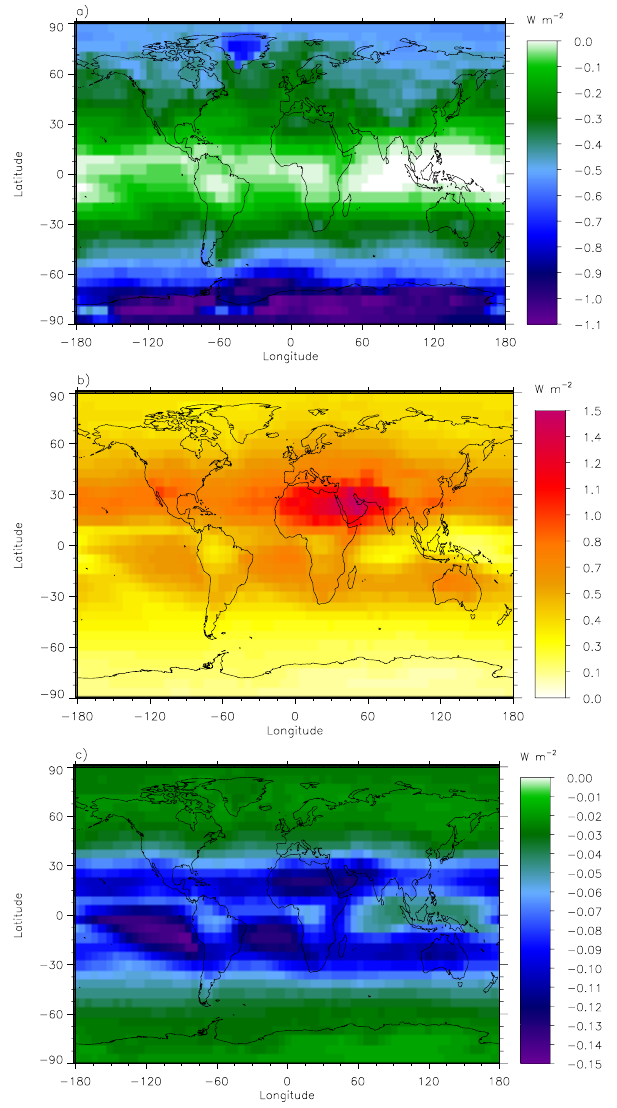
Fig. 8. The radiative forcing due to changes in atmospheric O 3 between the pre-industrial times and the present, for the R2 simu- lations. (a) shows the RF for the change in stratospheric O 3 , (b) the RF for the change in tropospheric O 3 , while (c) shows the RF difference for changes in tropospheric O 3 between R2 and